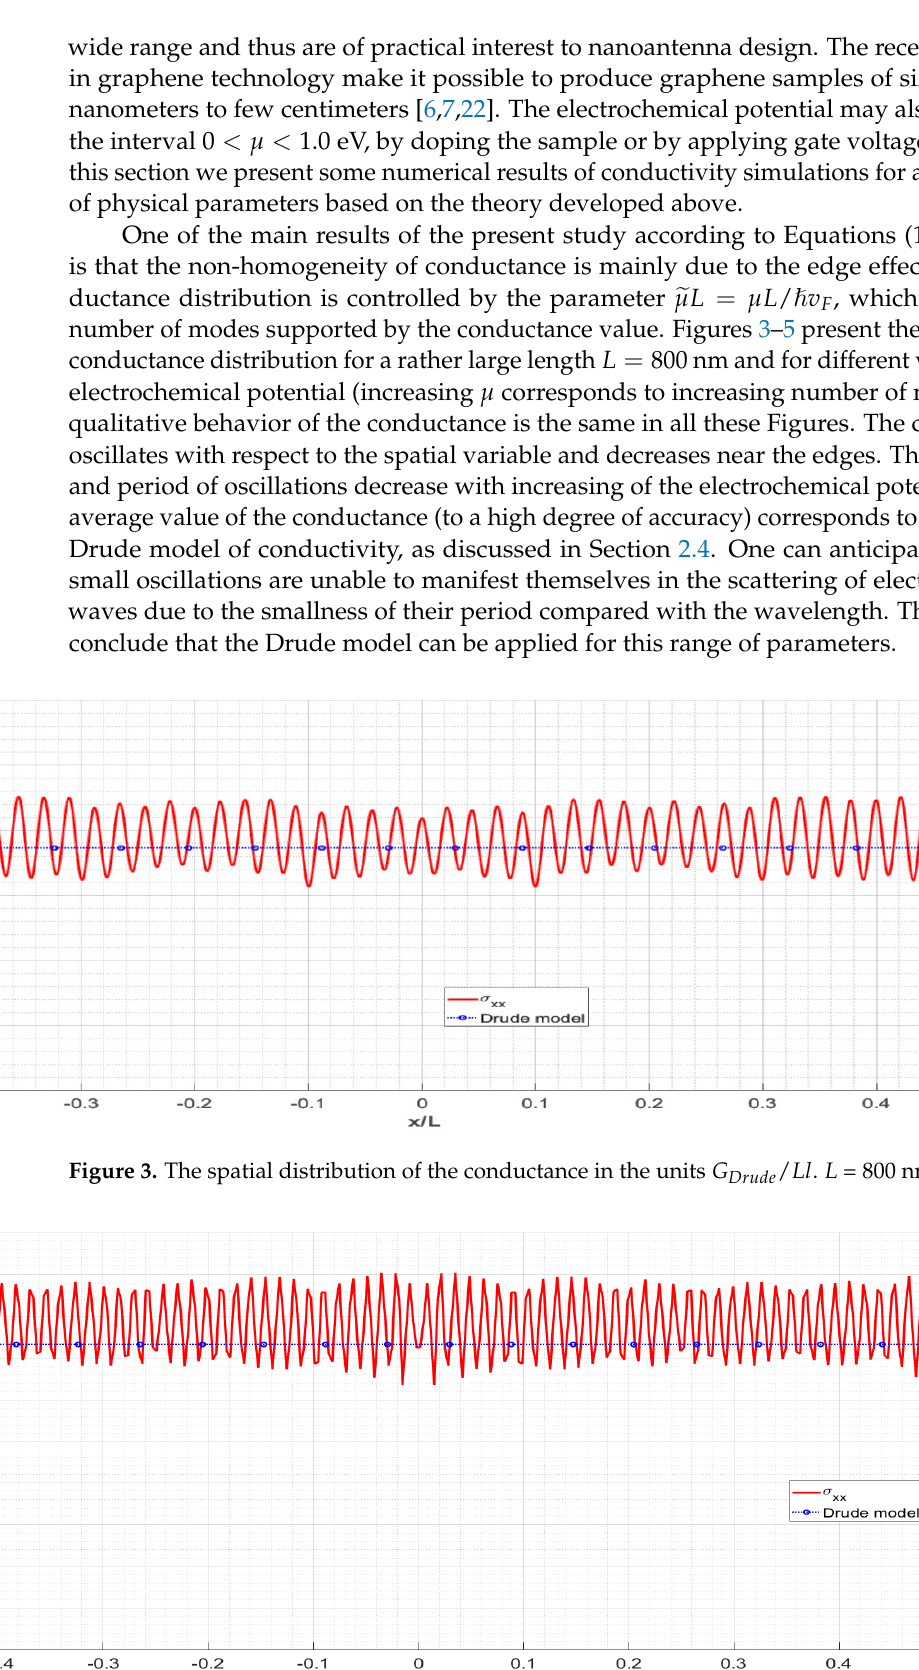
Figure 4. The spatial distribution of the conductance in the units G Drude / Ll . L = 800 nm, µ = 0.5 eV.